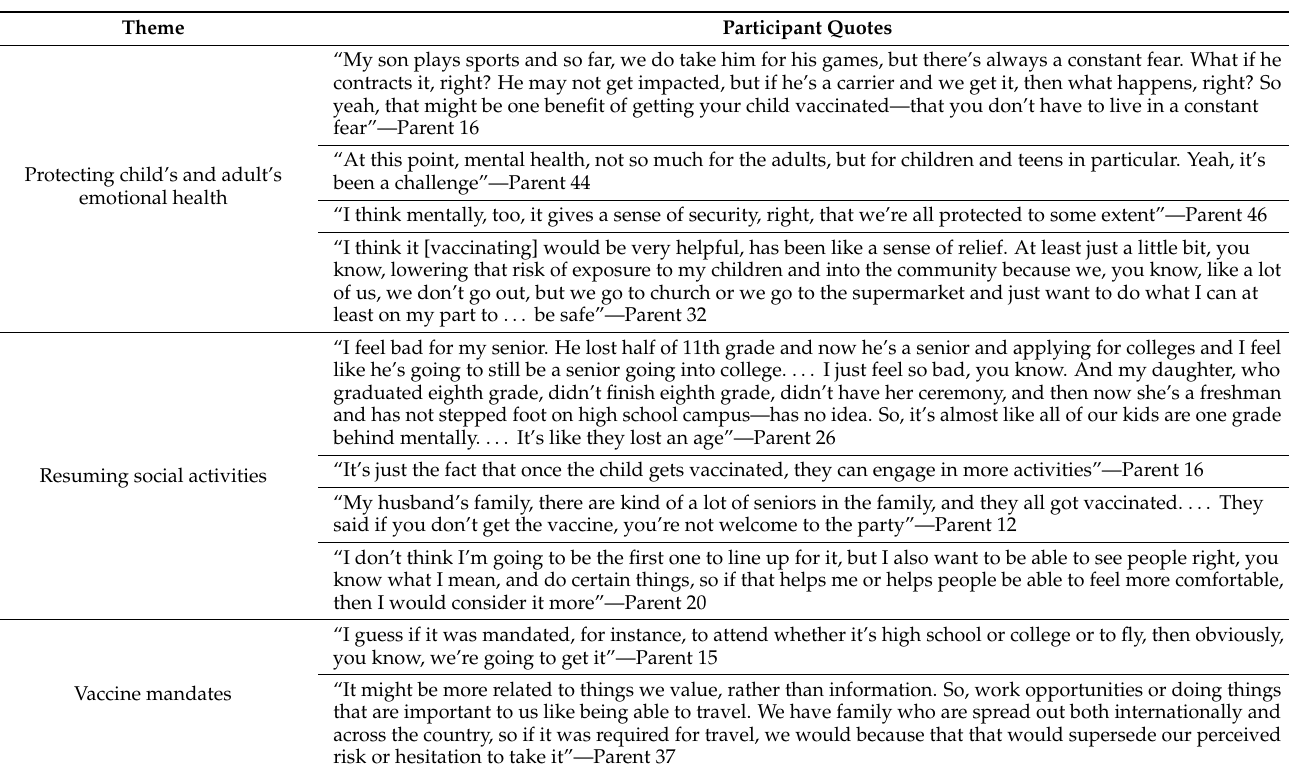
Table 6. Pandemic-Related Factors in COVID-19 Vaccine